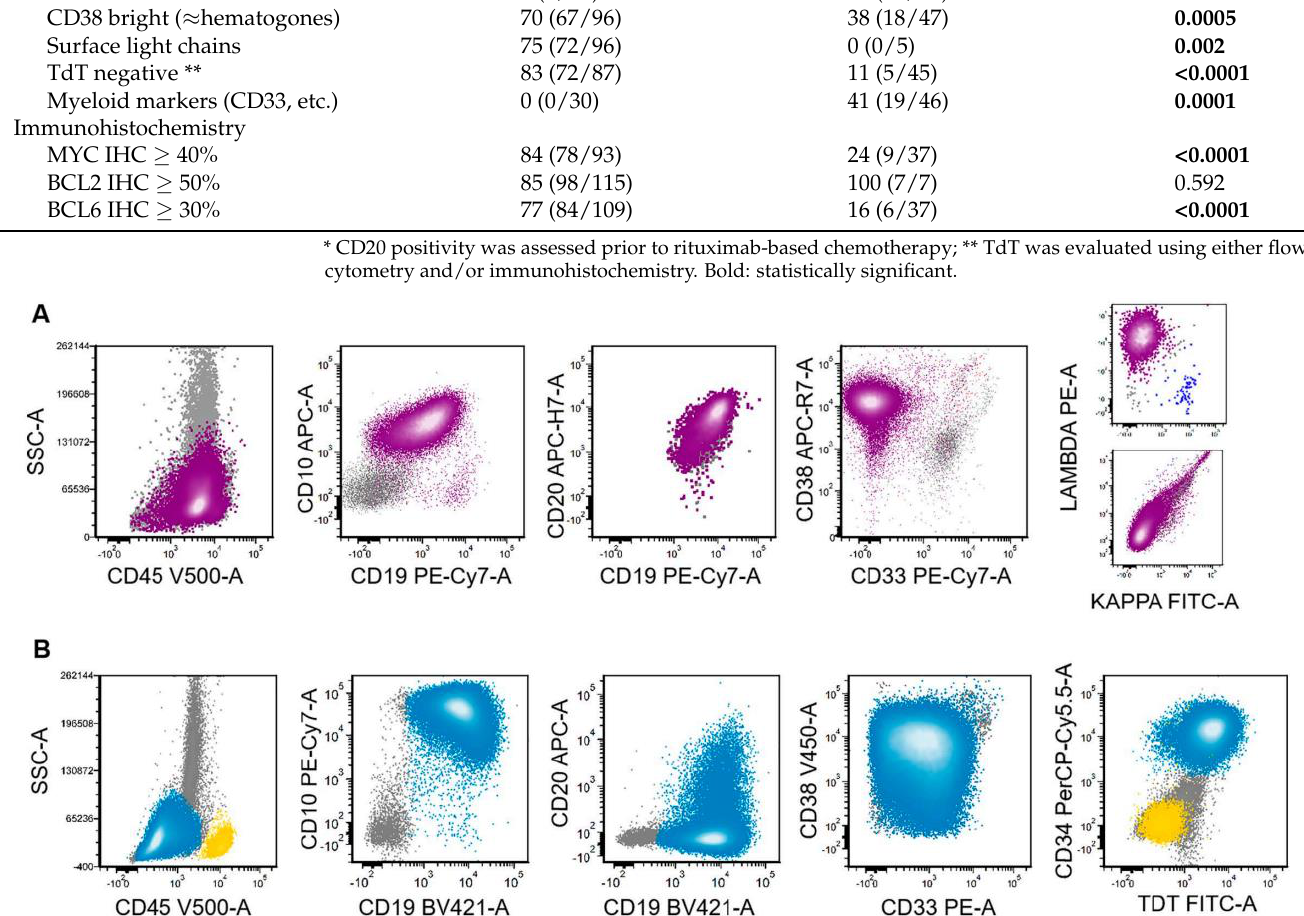
( p = 0.0001). TdT often showed strong expression in all or a large subset of lymphoblasts in B-ALL, in contrast with variable expression in a small subset of lymphoma cells in blastoid HGBL (Figure 1). The frequency of BCL2 overexpression was similar between blastoid-HGBL and B-ALL cases ( p = 0.592), but staining intensity was more variable